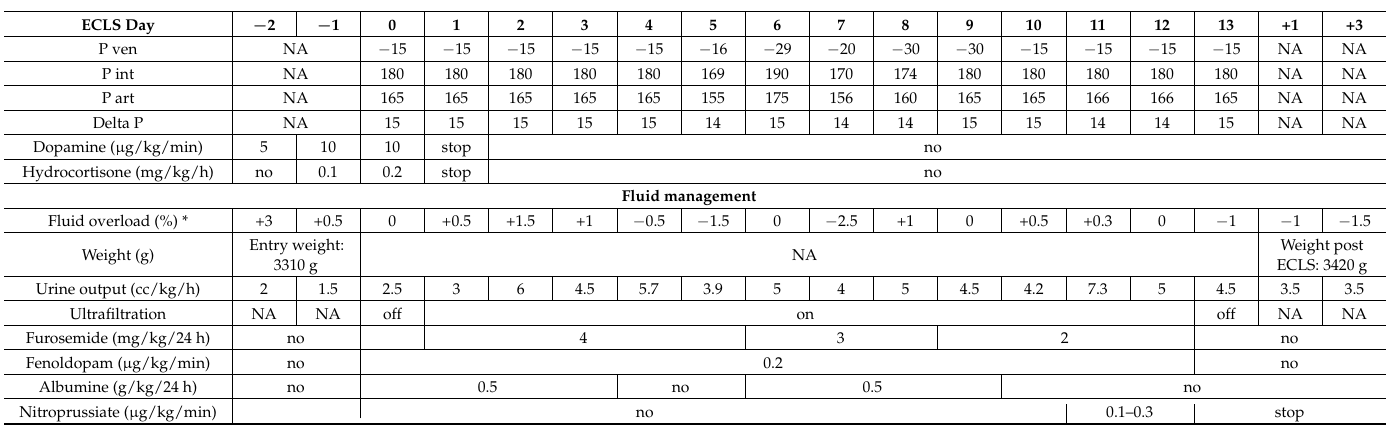
* Table 1 Trend of vital parameters, gas analysis main values, respiratory and circulatory settings before ECLS (day − 2, − 1), during ECLS (days 0–13) and after ECLS discontinuation (day +1, +3). ECLS: extracorporeal life support; SD: standard deviation; HR: heart rate; SpO 2 : peripheral arterial oxygen saturation; AP: arterial pressure; SvO 2 : central venous oxygen saturation; BE: base excess; pO 2 : partial pressure of oxygen; pCO 2 : partial pressure of carbon dioxide; FiO 2 : fraction of inspired oxygen; PC/AC: pressure controlled/assisted controlled; HFO: high frequency oscillatory ventilation; NIV non-invasive ventilation; PIP: peak pressure; PEEP: positive end-expiratory pressure; Paw: mean airway pressure; RR: respiratory rate; Hz: hertz; Ti: inspiratory time; I:E: inspiration/expiration ratio; Vt: tidal volume; OI: Oxygenation index; BAL: bronchoalveolar lavage; LPM: liters per minute; UF: ultrafiltration; RPM: revolutions per minute; Fluid overload (%) = [(fluids IN–fluids OUT)/entry weight ] × 100; h: